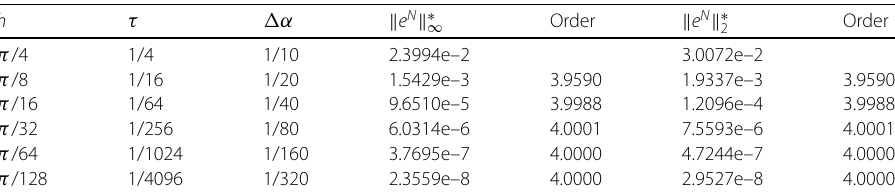
Table 5 The discrete L 2 errors, maximum errors, and convergence rates for scheme (16) for Example 2 with v 1 = 0.1 and v 2 =